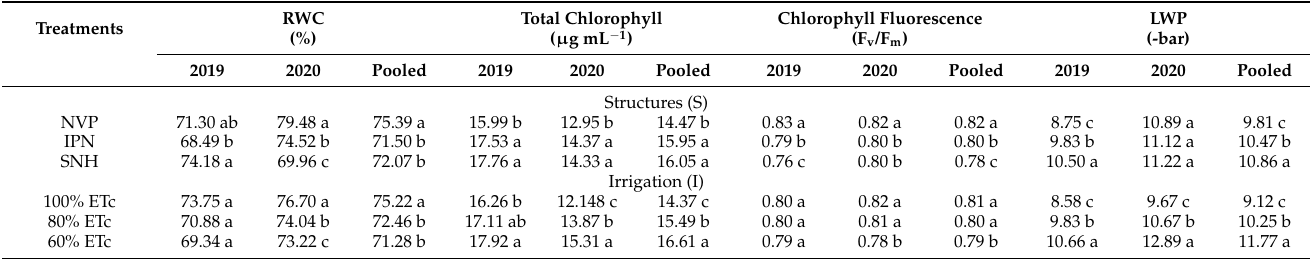
Table 8. Effect of protected structures and irrigation levels on physiological parameters of